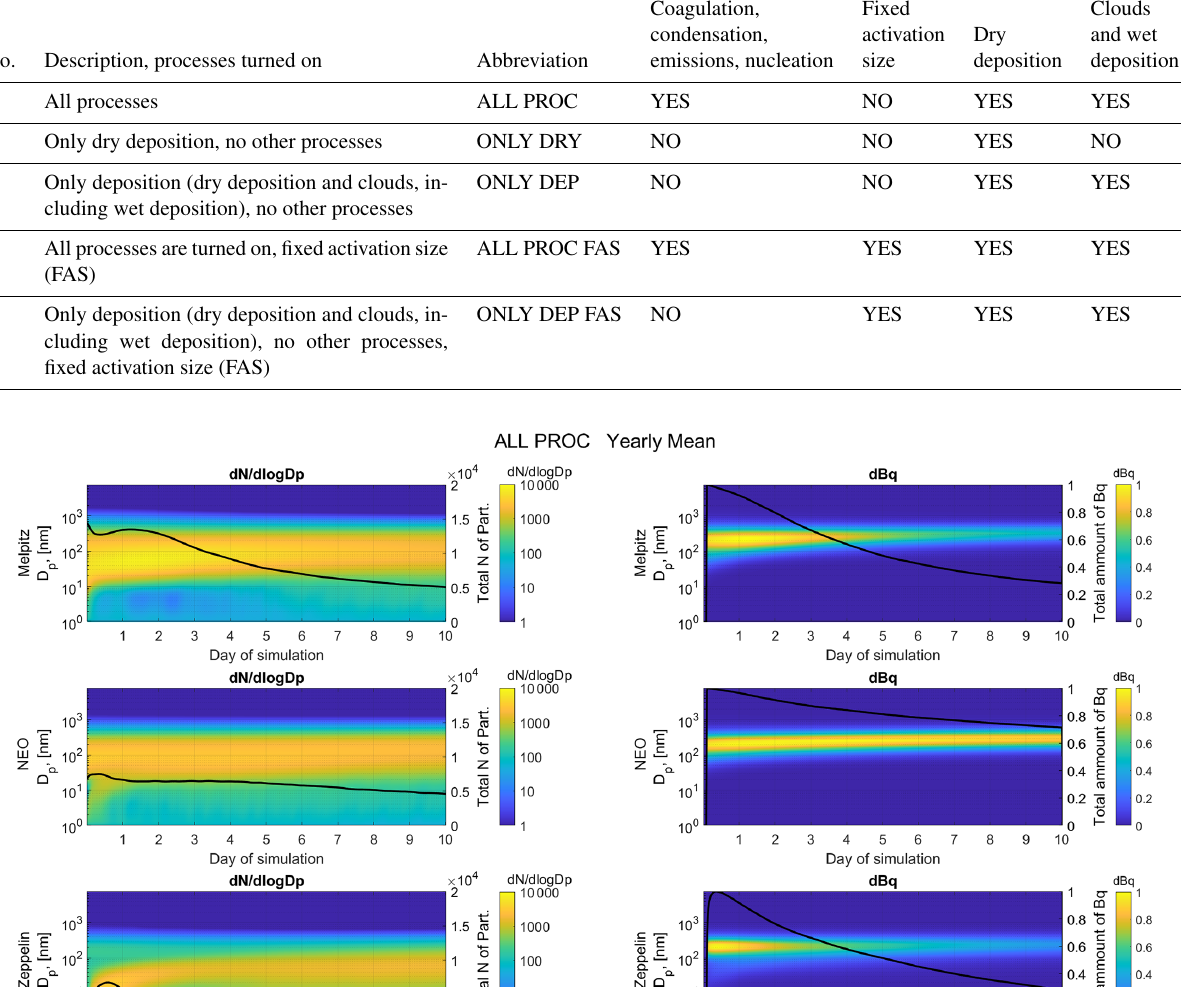
velopment over the 10 d period is an effect of different routes of the individual trajectories, meteorological conditions, new sources and aerosol processes along the path. Even though each track has its individual characteristics and events, an- nual and monthly averages show features representative for each site and period. The radioactive caesium is released 1 h into each simulation and condensates on currently available particles to be mixed with “clean” particles from new sources along the path. For Melpitz, the average PNSD decreases after an initial peak 1 d into the simulation. The peak in the PNSD